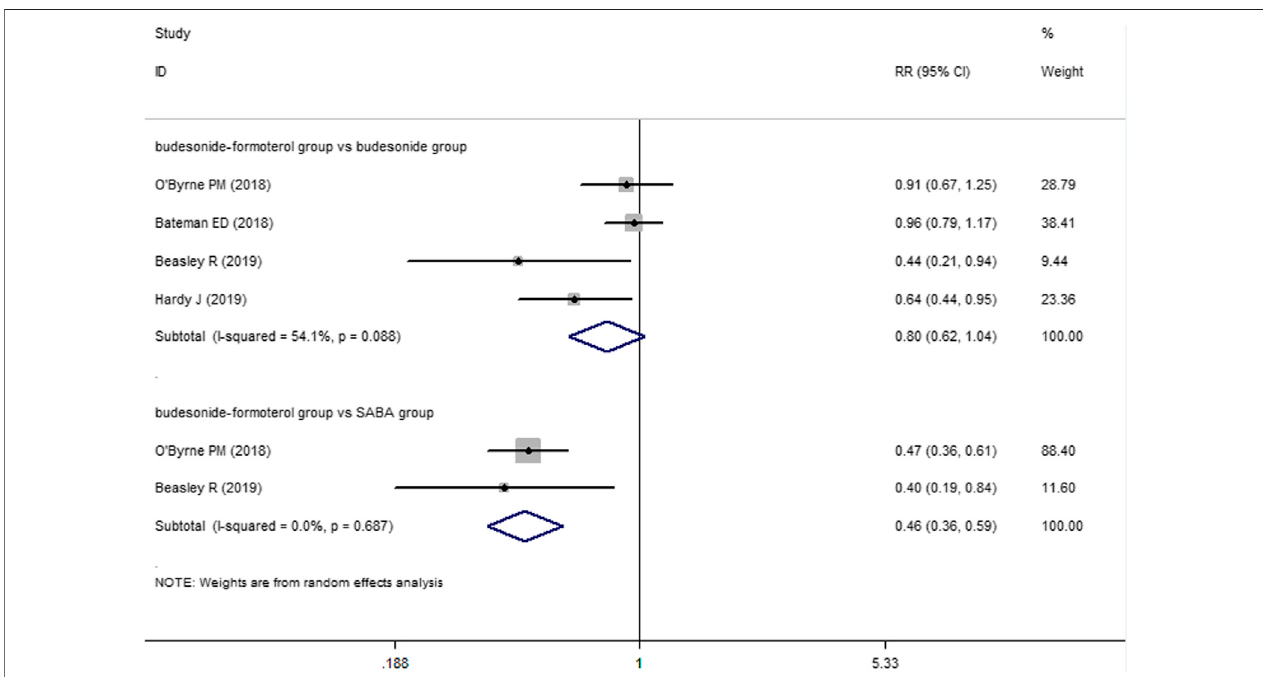
FIGURE 2 | Comparison of the difference of severe exacerbations patients in the three treatment groups.